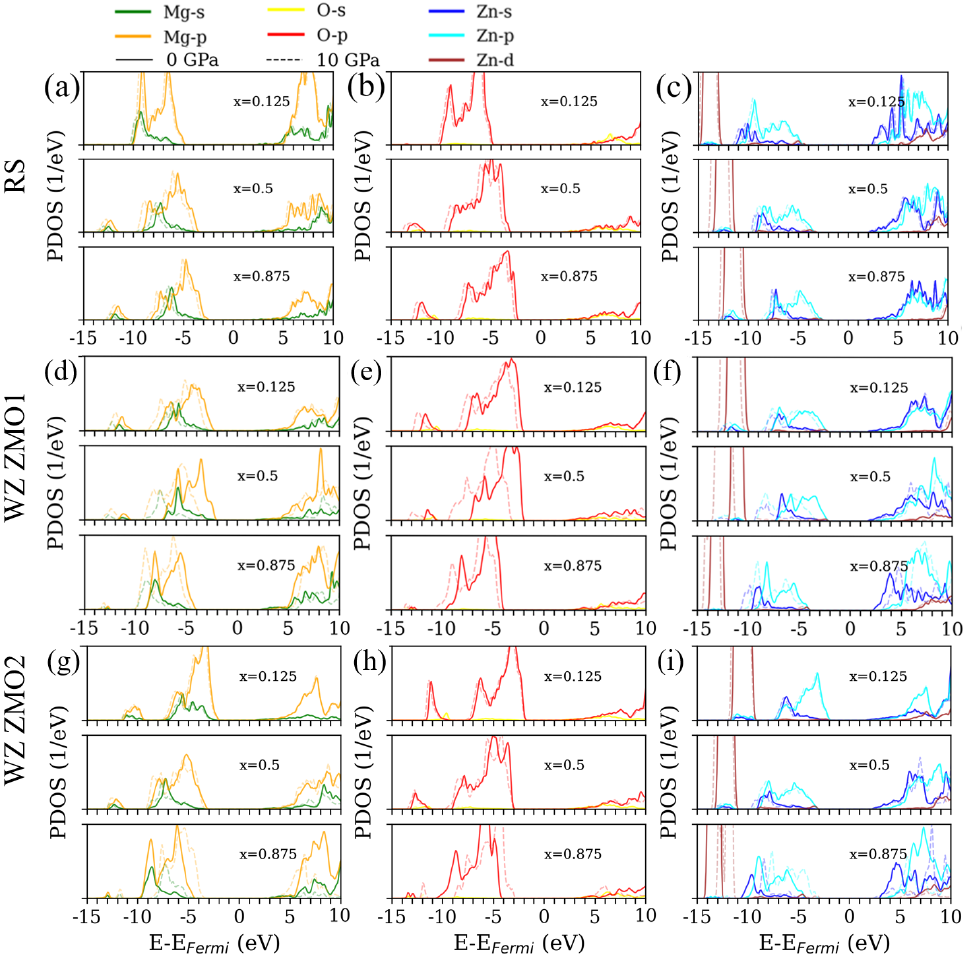
Figure 5. Partial densities of states (PDOS) of rocksalt (RS) Mg 1 − x Zn x O and wurtzite (WZ) Zn 1 − x Mg x O at different concentrations (x = 0.125, 0.5 and 0.875). The RS ZMO ( a – c ), WZ ZMO1 ( d – f ) and WZ ZMO2 ( g – i ) are shown in Figure 1. The first, second and third columns correspond to magnesium, oxygen and zinc, respectively. The upper, medium and bottom panels are related to the concentrations of x = 0.125, 0.5 and 0.875 in each sub-figure. The colors green, orange, yellow, red, blue, cyan and brown correspond to the Mg– s , Mg– p , O– s , O– p , Zn– s , Zn– p and Zn– d states, respectively. The solid and dashed lines individually present the 0 and 10 GPa. The Fermi level is set to zero. The detailed PDOS of the ZMO models for x = 0.125, 0.5 and 0.875 with the pressure from 0 GPa to 10 GPa in 2 GPa increments can be found in Appendix B, which features Figure A1 for the RS models, Figure A2 for the WZ ZMO1 models and Figure A3 for the WZ ZMO2. The calculated partial densities of states (PDOS) for the WZ ZMO1 and WZ